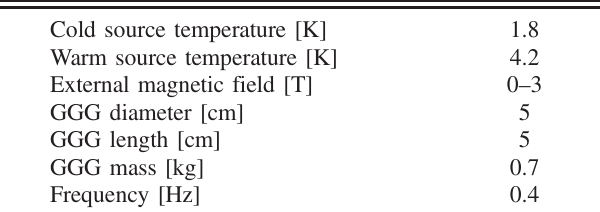
FIG. 6. Thermal diffusivity change during complete